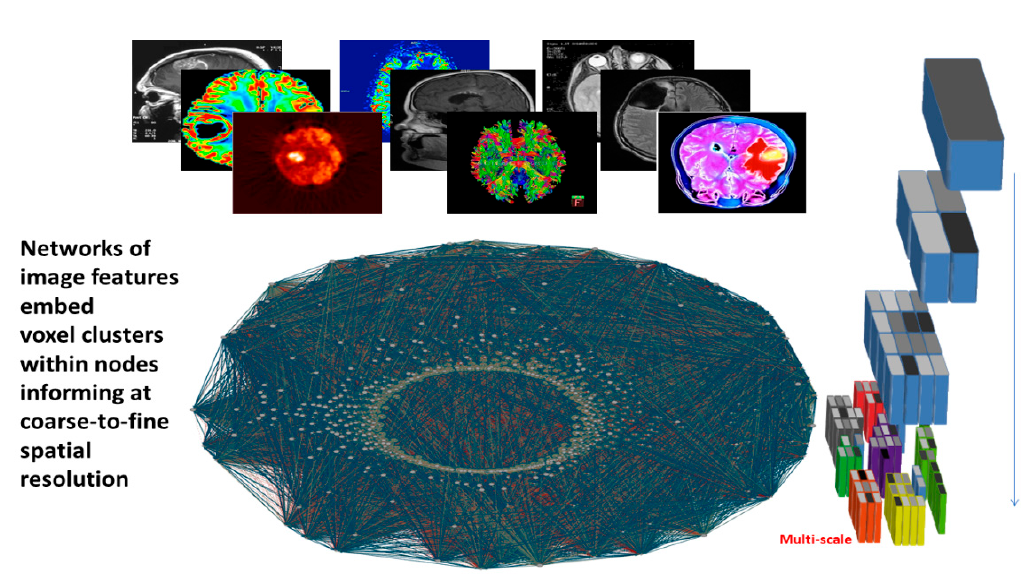
Figure 5. Use of networks to determine ideal treatment ( c ) and treatment follow-up ( d ). In the top panel the goal is to solve the tumor by acting on its nodes. Assuming that state A had defined the tumor nodes, state B measures the effects of ablations that destroy the communications between such nodes. The bottom panel measures the efficacy of treatment by tracking the shape of states (ex-ante and ex-post compared to treatment).